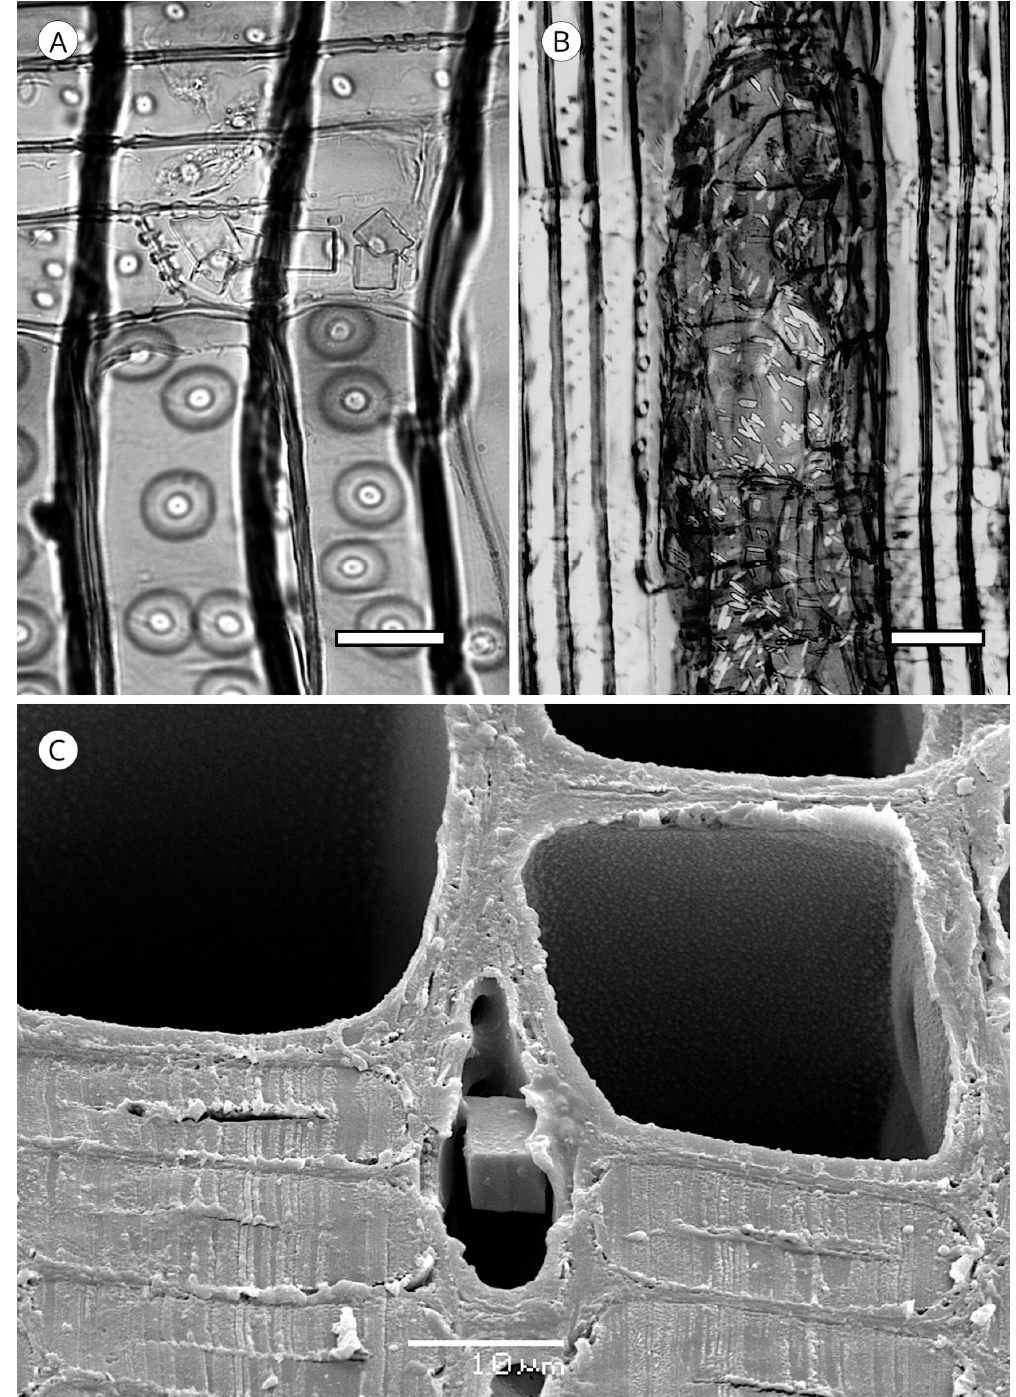
Figure 42. Crystals. ( A ) Crystals in ray parenchyma of Abies firma Siebold and Zucc.; ( B ) Cubic and styloid crystals in epithelial cells of axial resin canal in Pinus bungeana Zucc. ex Endl.; ( C ) Crystals in ray parenchyma of Abies nordmanniana subsp. equi-trojani (Asch. & Sint. ex Boiss.) Coode and Cullen. Scale bars. ( A ) = 25 μ m; ( B ) = 100 μ m.